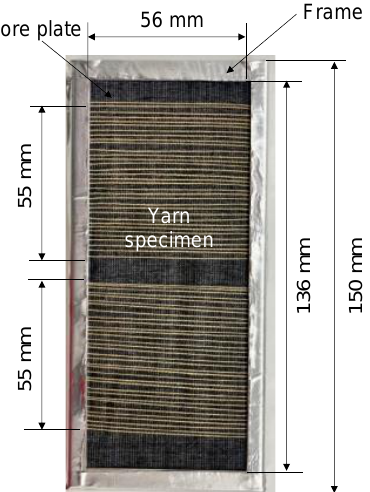
Figure 2. Yarn specimen placement for UV exposure in the test frame. The surface area of warp yarns exposed to UV light depends on the spacing between the warp yarns, and the tensile strength of the warp yarns changes with the surface area. When exposed to ultraviolet light, the tensile strength of the warp yarns with wide spacing between the warp yarns is lower than that of the warp yarns with narrow spacing. Therefore, the method of unraveling warp yarns was investigated in preparing the